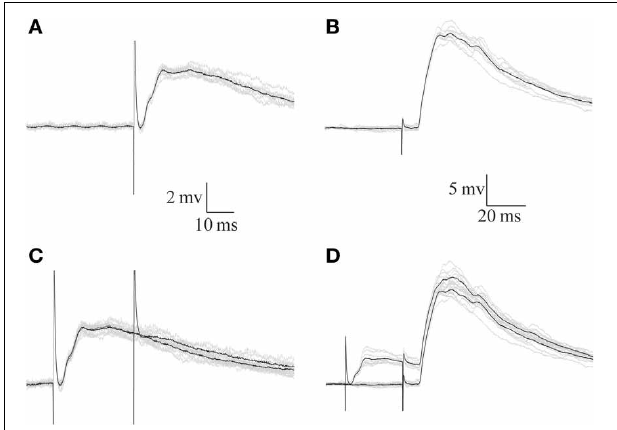
FIGURE 8 | The response evoked by parallel fibers stimulation is insensitive to the inhibition evoked by afferent nerve stimulation. (A,B) Synaptic potentials evoked by afferent nerve (A) and parallel fibers (B) stimulation. (C,D) Preceding the responses shown in (A,B) by afferent nerve stimulation eliminates the response to the same stimulus (C) but does not affect the response to parallel fibers stimulation (D) Black traces show the averages of the 10 traces (gray) in each